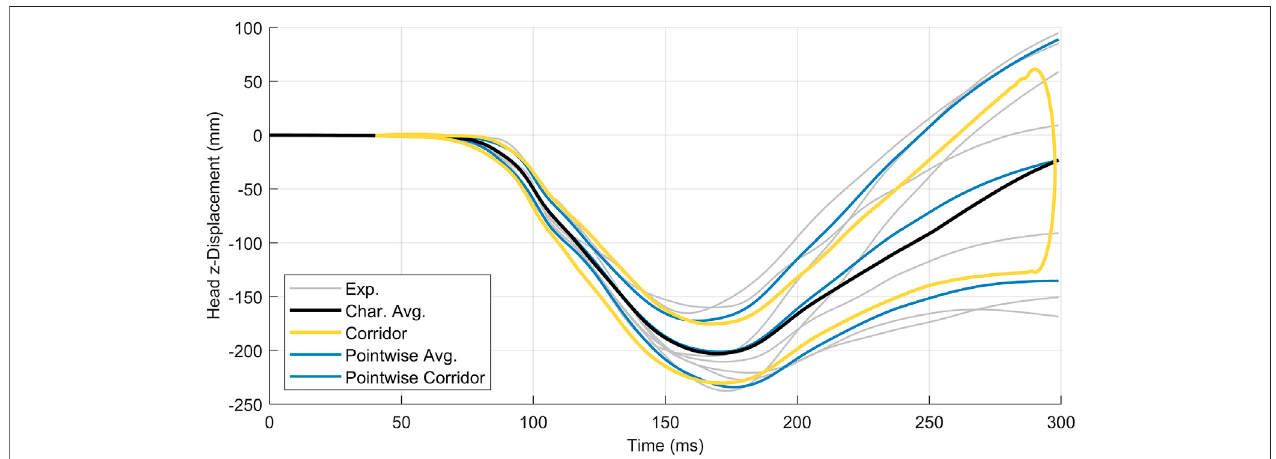
FIGURE 11 | Head z-displacement for seven subjects, with the characteristic average curve (black) compared to the point-wise average (blue). Corridors are ± 1 standard deviation, m (cid:2) 2 control points, λ (cid:2) 10 − 2 .